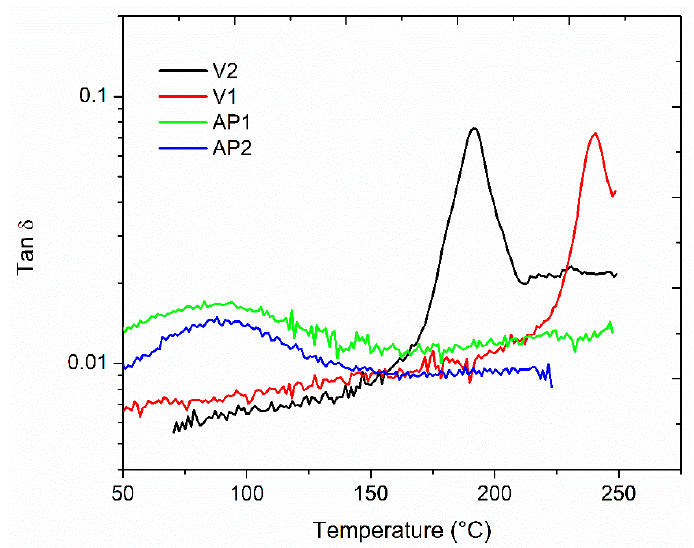
Figure 5. Tan δ versus temperature for the thermoplastic veils analyzed using supported dynamic mechanical analysis (DMA).